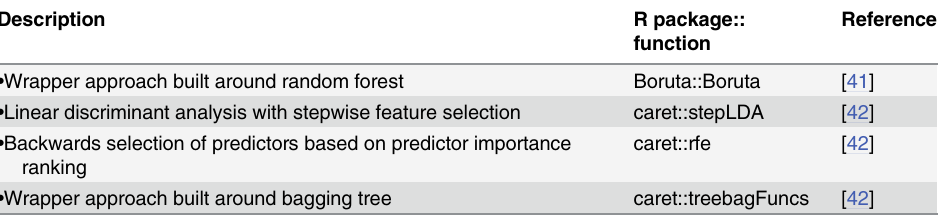
Table 2. Approaches and R packages applied for feature selection prior to statistical